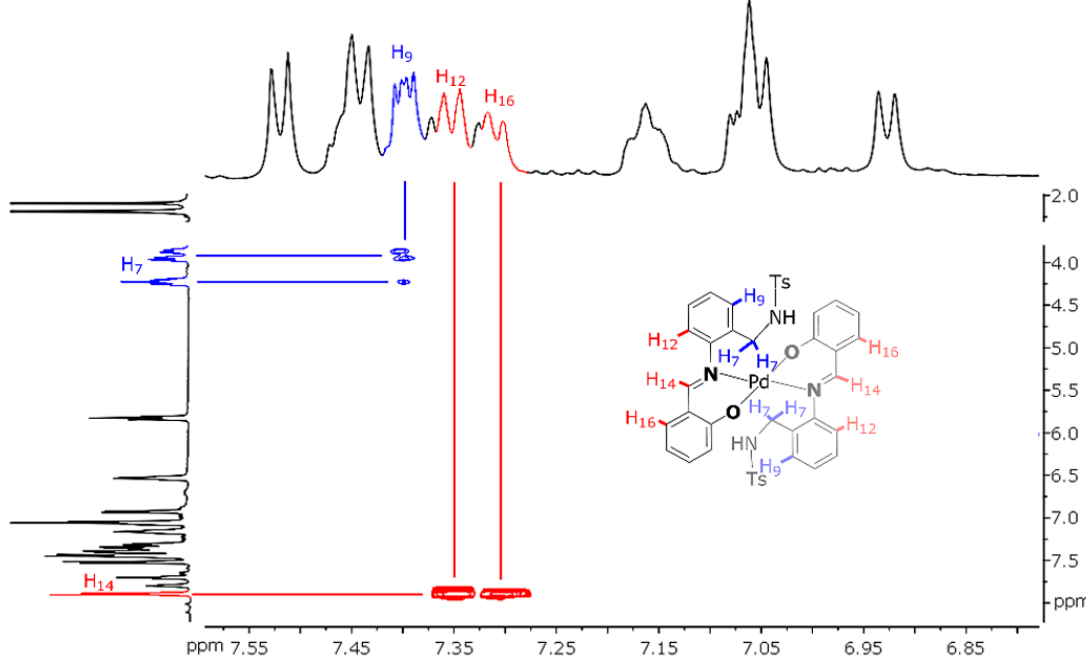
Figure 4. View of the NOESY spectrum of Pd(HSB) 2 (in dmso ‐ d 6 ), with schematic representation of the metal complex (inset).